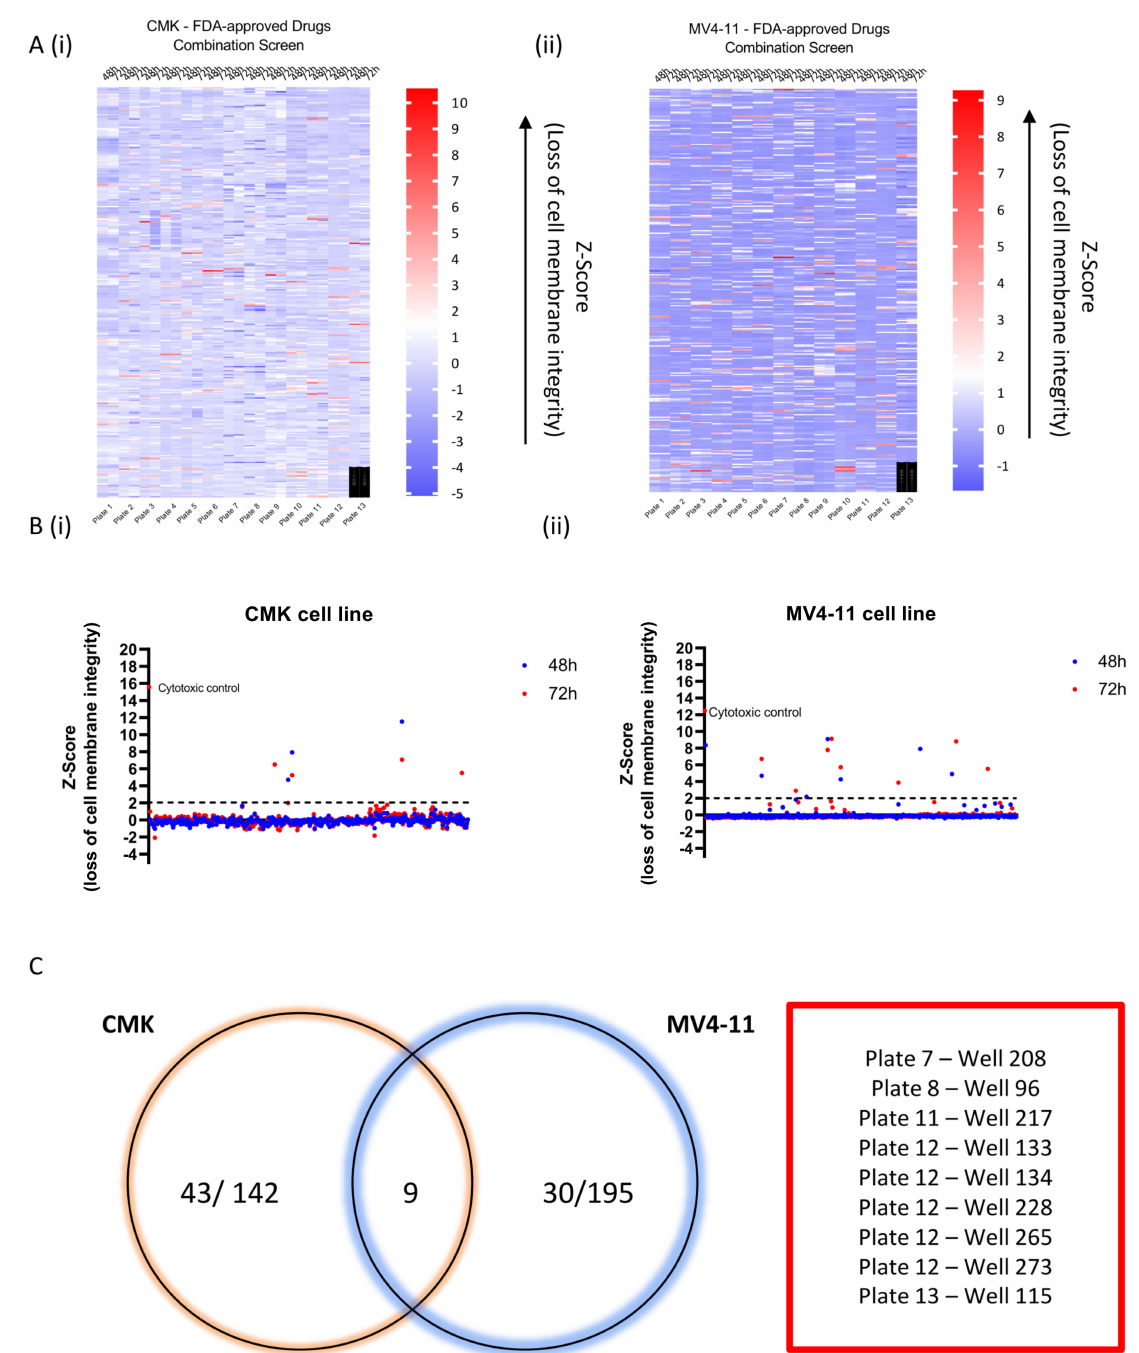
Figure 1. High-throughput screening of paediatric AML cell lines in vitro. All possible pairwise combinations of 384 FDA- approved compounds were assessed (~72,000 wells). An algorithm developed in-house grouped the compounds into pools of 10 compounds per well, reducing the number of wells to 3878. Z-scores were calculated for each of the combinations based on the mean and standard deviation of the normalised relative fluorescence unit (RFU) values. ( A ) Heatmap of the Z-score for each of the 3878 combinations. Time point along the top and the plate number along the bottom. ( i ) CMK; ( ii ) MV4-11. A Z-score > 2 was shown to cause significant loss of membrane integrity correlating with the induction of cell death. ( B ) Graph demonstrating the Z-score of each of the 384 single agents following a 48 and 72 h incubation. ( i ) CMK; ( ii ) MV4-11. ( C ) Venn diagram summarising the successful wells (combination demonstrated a Z-score > 2, while each of the compounds in the well demonstrates minimal single-agent activity) that were common and unique across the cell lines at 72